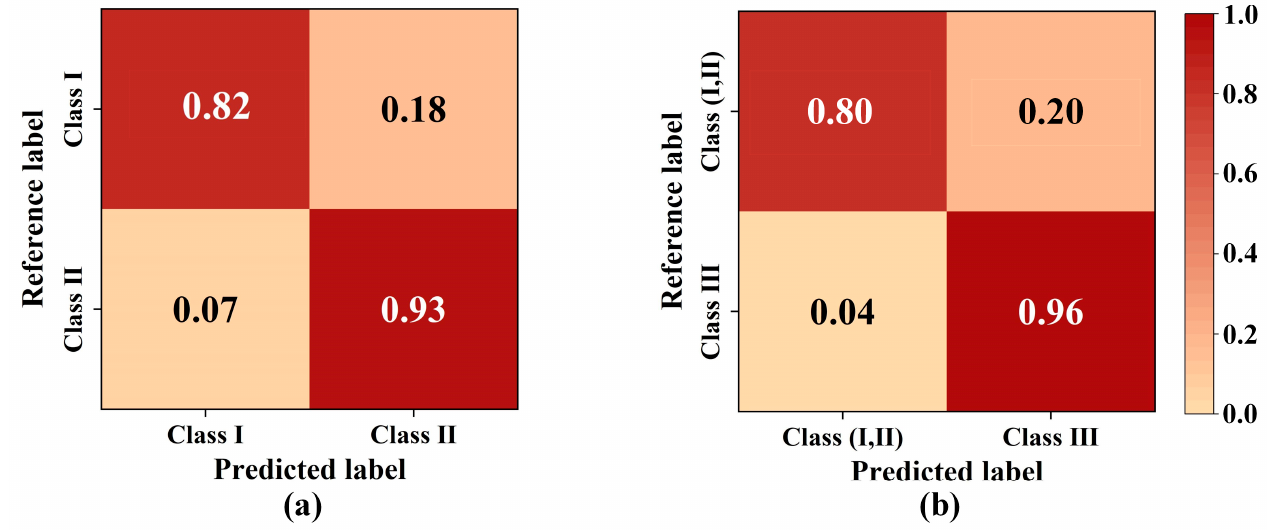
Figure 6. Confusion matrices for first ( a ) and second ( b ) step classification based on the optimized 1D-CNN model.